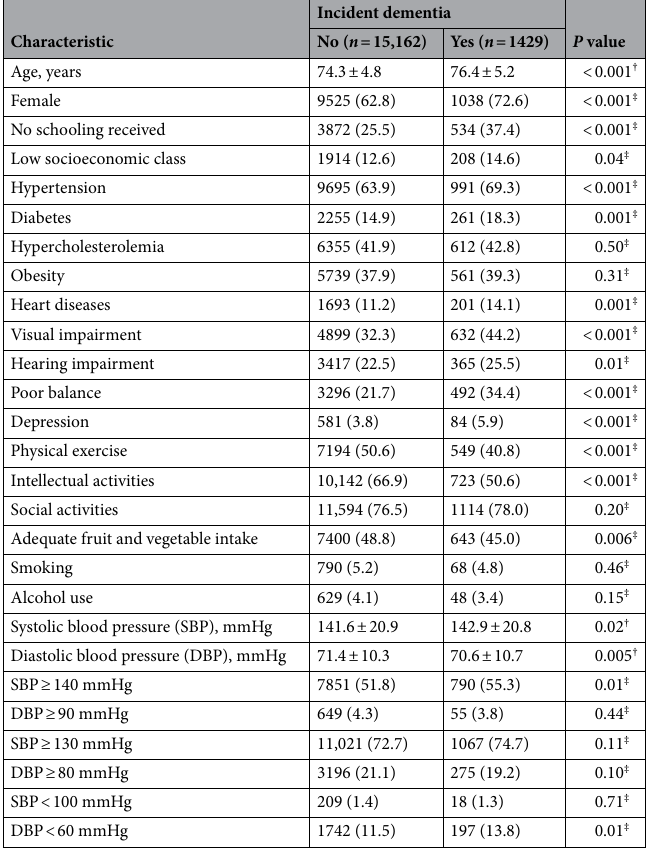
Table 1. Comparison of baseline characteristics between older adults with and without incident dementia in 6 years. Values are mean ± standard deviation for continuous variables as determined by the independent t-test † , and n (%) for categorical variables as determined by the χ 2 test ‡